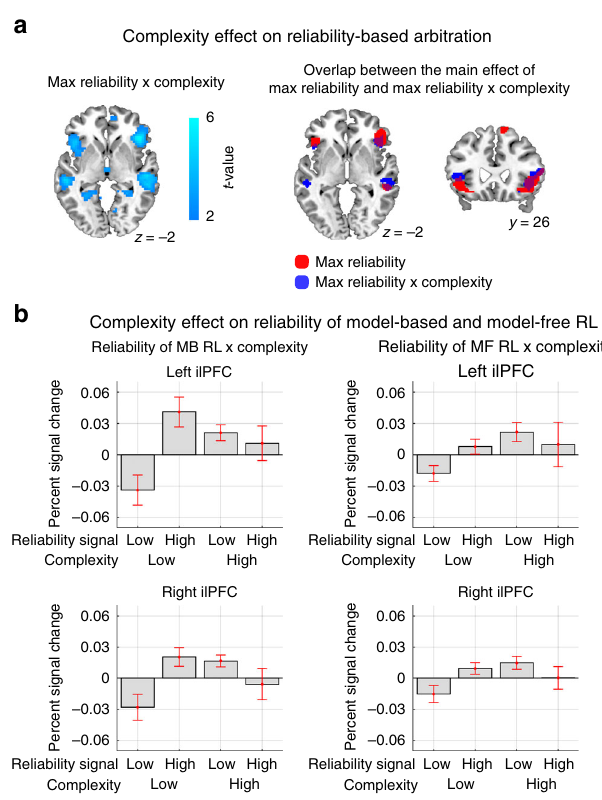
Fig. 9 Modulation of inferior prefrontal reliability by complexity. a (Left) Bilateral ilPFC was found to exhibit a signi fi cant interaction between complexity and reliability (Max reliability × complexity). Statistical signi fi cance of the negative effects is illustrated by the cyan colormap. The threshold is set at p < 0.005. (Right) The brain region re fl ecting the interaction effect largely overlaps with the brain area implicated in arbitration control. The red and blue regions refers to the main effect of max reliability and the interaction between reliability and task complexity, respectively, thresholded at p < 0.001. b Plot of average signal change extracted from left and right ilPFC clusters showing the interaction, shown separately for reliability signals derived from the MF and MB controllers. Data are split into two equal-sized bins according to the 50th and 100th percentile of the reliability signal, and shown for the trials in the low and high complexity condition separately. The error bars are SEM across